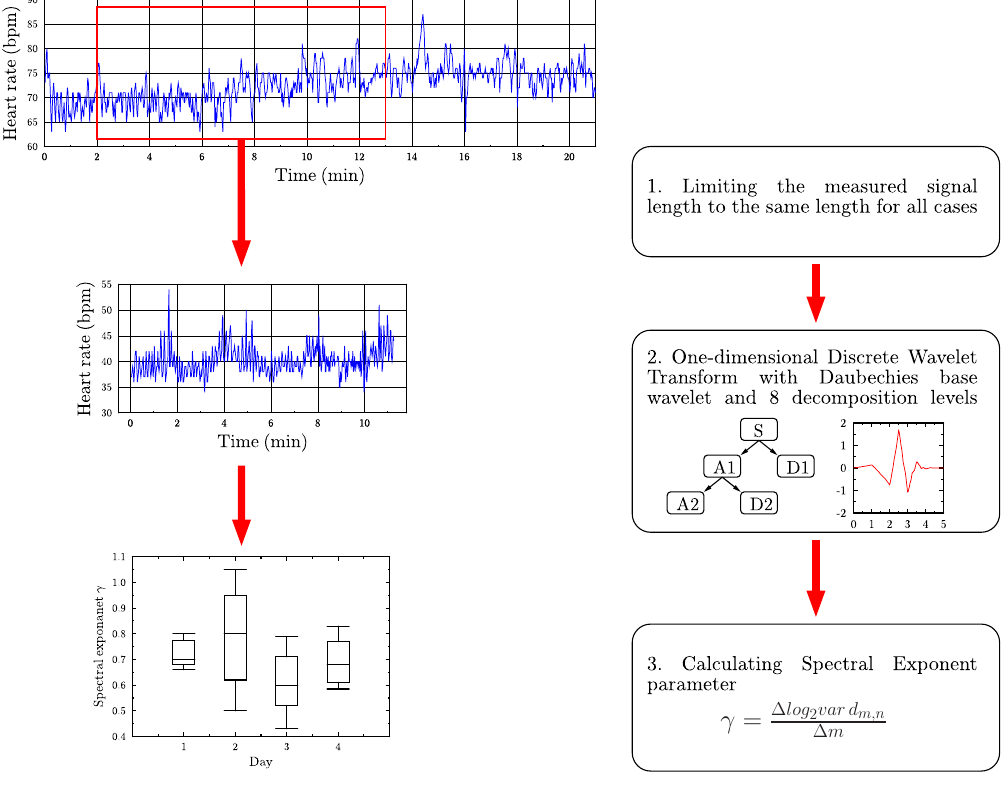
Figure 2. A schematic diagram for the signal analysis methodology based of the application of DWT, used for calculation of spectral exponent